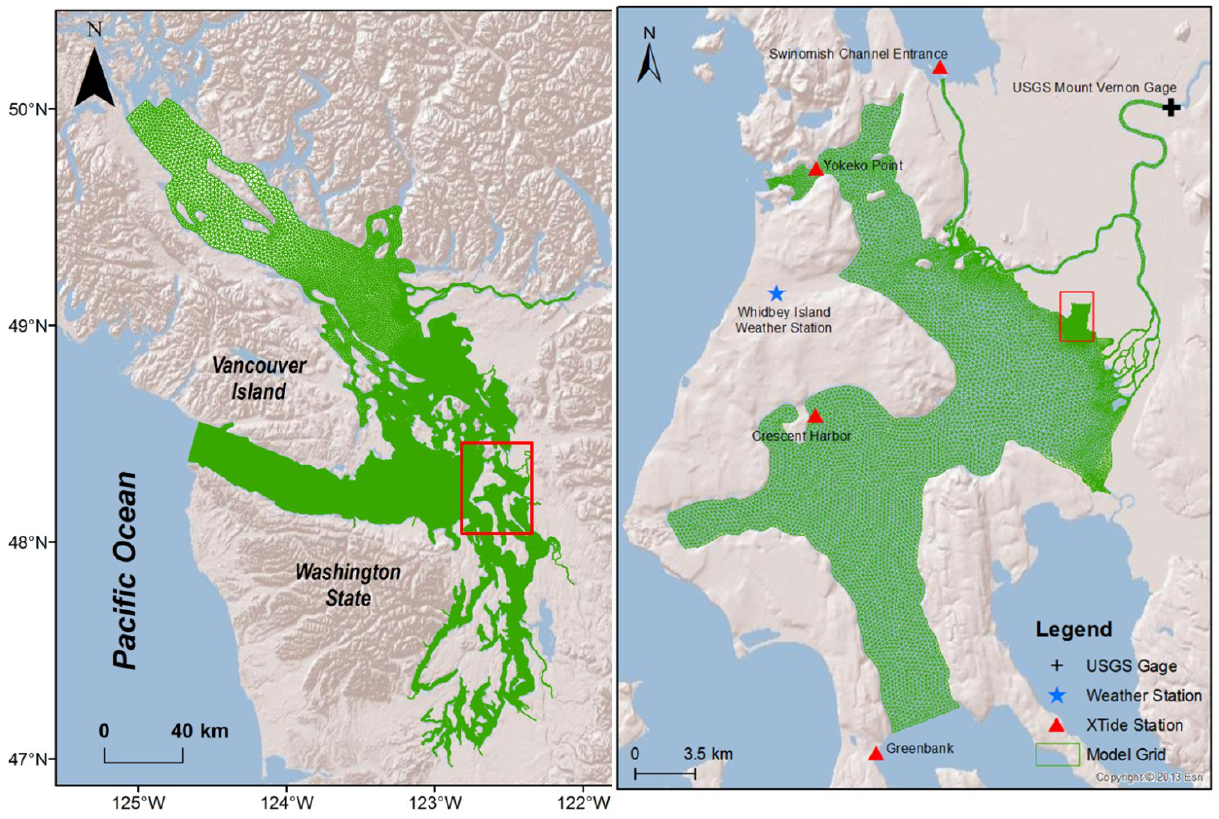
Figure 3. (Finite volume coastal ocean model) FVCOM grids of Puget Sound ( left ) and Skagit River Estuary ( right